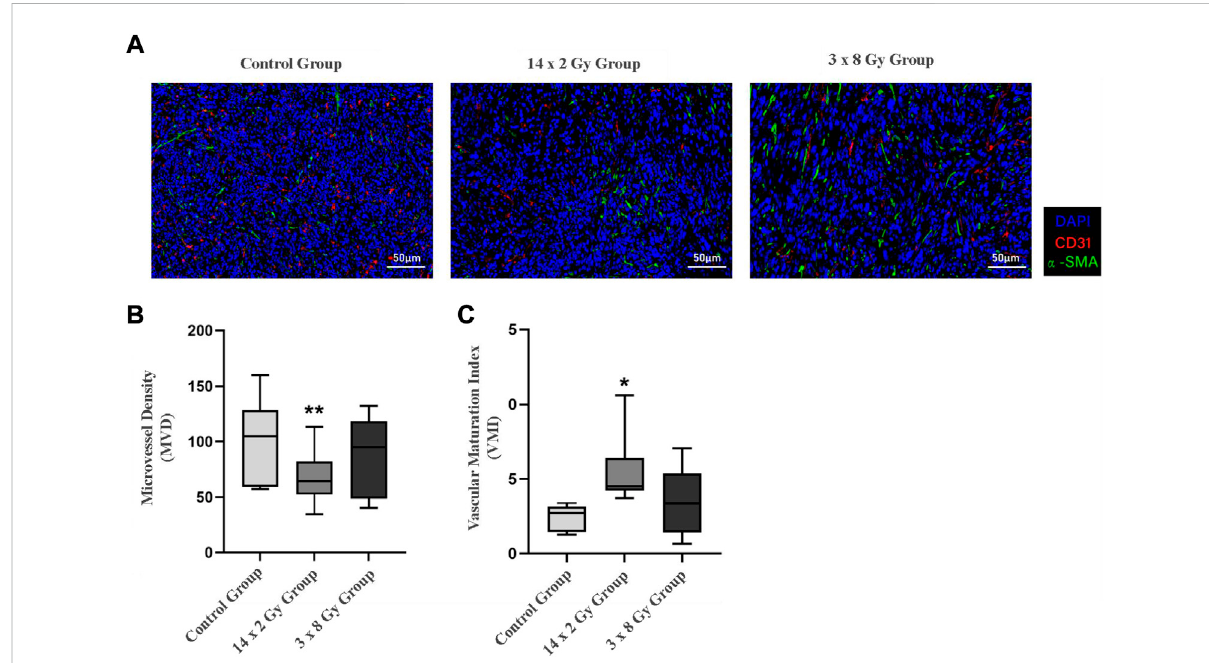
FIGURE 5 Immuno fl uorescenceanalysisof4T1breasttumors afterirradiationatdifferentdoses. (A) Showsdouble-markerimmuno fl uorescenceofCD31 (red) and α -SMA (green), and the blue area represents the nucleus. (B) Indicates the quantitative expression of microvessel density (MVD) in tumor after radiotherapy. (C) Indicates the change of vascular maturity index (VMI) after radiotherapy. Compared with control the control group, * p < 0.05; Compared with control the control group, ** p <